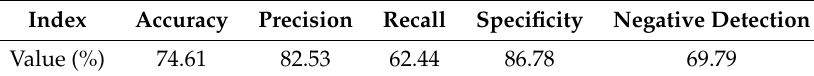
Table 29. Detection evaluation indices.